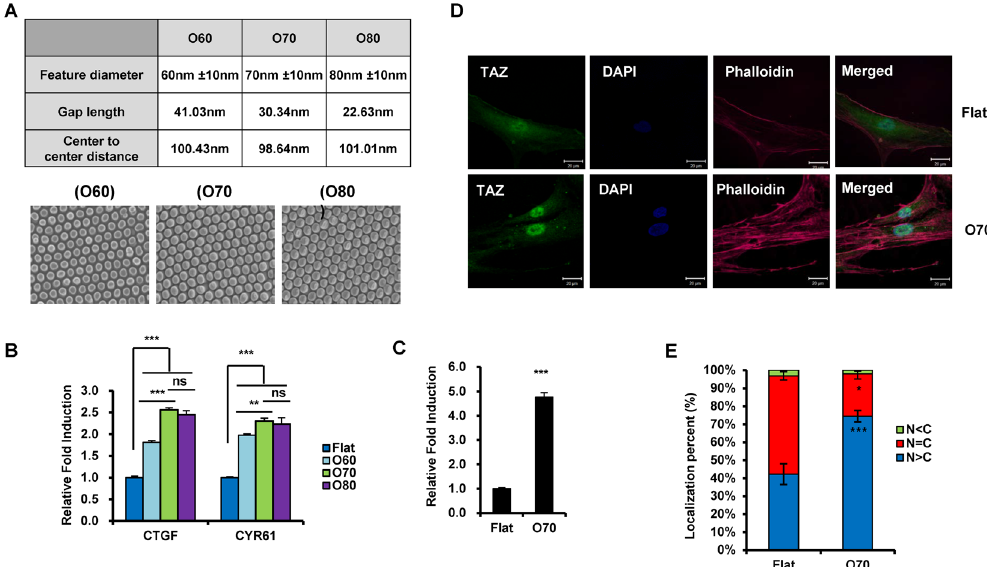
Figure 2. The O70 nanopattern plate is optimal for TAZ nuclear localization and activation. ( A ) Features of the O60, O70, and O80 nanopattern plates. Feature diameter, gap length between features, and the distance of the center-to-center were listed, and the SEM image of each nanopattern plate is shown. ( B ) MSC were seeded on flat or nanopattern plates and harvested after 48 hr. Transcript levels of CTGF and CYR61 were analyzed by quantitative real-time PCR. Asterisks mean statistical significance. n = 3, ** p < 0.01, *** p < 0.005, ns = not significant, t-test. ( C ) MSC were transfected with CTGF-luc. After 16 hr, cells were re-seeded on flat or nanopattern plates, and luciferase activity was measured using a luciferase reporter gene assay system 24 hr after re-seeding. n = 3, *** p < 0.005, t-test. ( D ) MSC were seeded on flat or nanopattern plates and immunostained with TAZ specific antibody 24 hr after seeding. F-actin and the cell nucleus were counterstained with phalloidin and DAPI, respectively. ( E ) Immunostained cells in panel ( D ) were counted using the image J software, and the cell population for nuclear dominant, cytosol dominant, and evenly distributed TAZ was calculated. n = 3, * p < 0.05, *** p < 0.005,